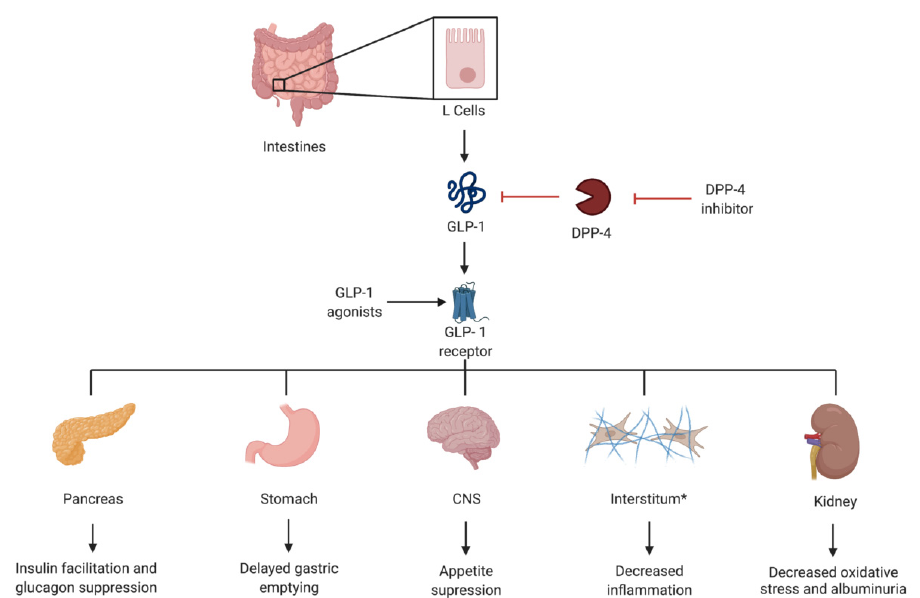
Figure 4. Visual representation of the mechanism of action of glucagon-like peptide 1 (GLP-1), as well as GLP-1 agonists and dipeptidyl peptidase-4 (DDP-4) inhibitors. * The anti-inflammatory effect has been noted in the heart and kidneys.